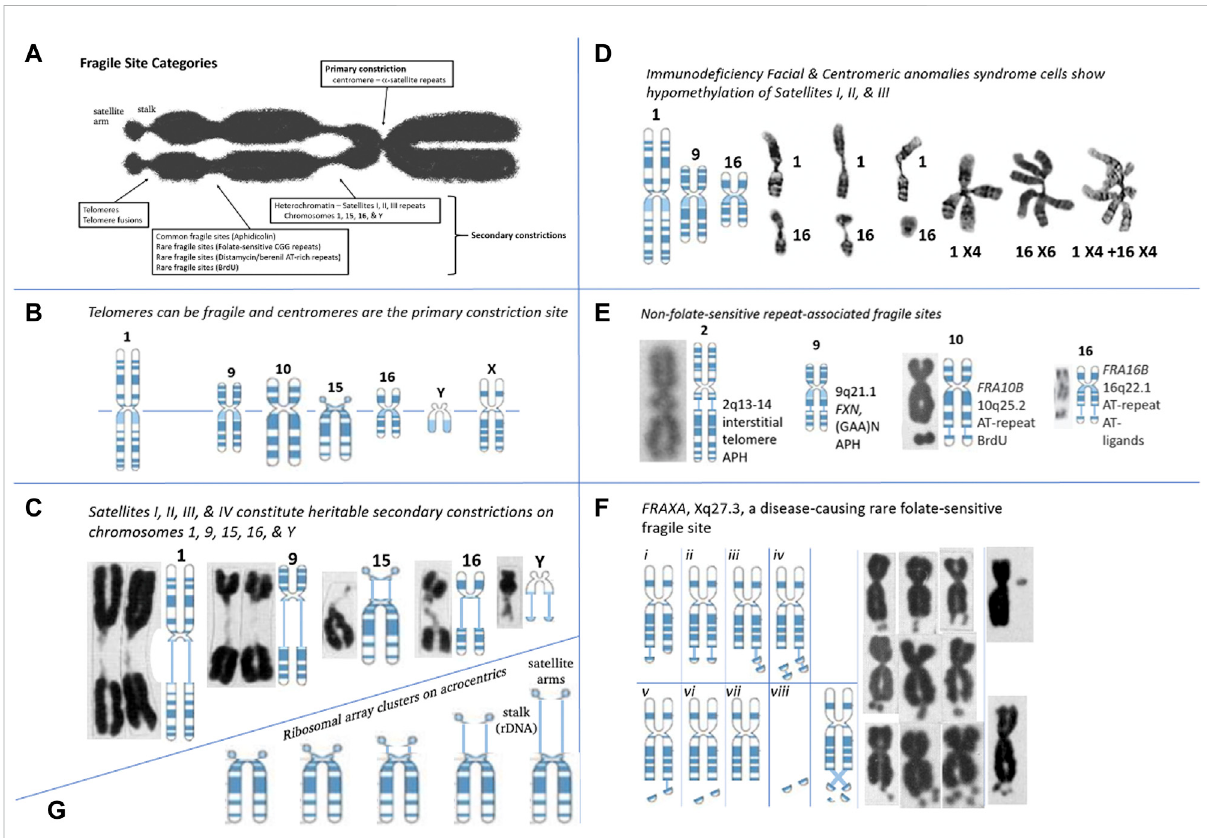
FIGURE 1 Repeat Tracts, fragile sites, and disease. (A) Categories of fragile site constrictions observable on human chromosomes. (B) Fragile sites can occuratthetelomereorcentromere,observedonchromosomes1,2,9,10,15,16,Y,andX.Telomereendsdisplay “ fragile-sitelike ” appearancesthat areTRF1-dependantandAPHinducible(Sfeiretal.,2009).Thecentromereofeverychromosomeisthe “ primaryconstriction, ” composedofrepeats. (C) Secondary constrictions are present on chromosomes 1, 9, 16, 15, and Y. Cytogeneticists were aware of these gaps prior to FRAXA and modeled it after the secondary constrictions (Lubs, 1969). These are composed of the classical satellite repeat DNAs, where four types (I-IV) of satellite DNA are located in the heterochromatic regions of chromosomes 1, 9, 15, 16, and Y, the total amount on these chromosomes and the proportion of the types being different (Vogt, 1990). Satellite regions of chromosomes 9 and Y, whose composition is the most complicated, and chromosome 15 is less complex, but like 9 and Y, it comprises all four types of satellite DNA. Chromosome 1 has type II satellite DNA, with the proportion of the remaining types being less. The C segment of chromosome 16 comprises only type II. The size/length of the secondary constrictions is highly-polymorphic amongst individuals, and segregates as a heritable state (Chromosomes: Guttenbach and Schmid, 1994). (D) In Immunode fi ciency,Centromericinstability&Facial anomalies(ICF) syndrome, satellitesI,II,andIIIofchromosomes1,9,and16arehypomethylated and show secondary constrictions within these regions. ICF syndrome was recently shown to be caused by four mutations in four genes: ICF1/ DNMT3B , ICF2/ZBTB24 , ICF3/CDCA7 ,and ICF4/HELLS (vandenBoogaardetal.,2017).Satellite-containingregionsonchromosomes1,9,and16are hypomethylated in individuals affected by ICF syndrome, and these show a variety of aberrant chromosomes: secondary constrictions, multibranched chromosome arms, whole arm deletions, duplications, isochromosomes, and centromeric fragility. As with fragile sites, these involved double-strand DNA breaks (Sawyer et al., 1995; Tuck-Muller et al., 2000). (Chromosomes: Tuck-Muller et al., 2000). (E) Many non-folate sensitive fragile sites have been mapped at repetitive regions. The interstitial telomeric repeat on chromosome 2, the AT-repeats of FRA10B and FRA16B,andtheGAArepeatof FXN onchromosome9has “ fragile-like ” characteristics.Fragilesiteat2q13-14ataninterstitialinvertedhead-to-head array of the telomeric repeat (TAGAGGG)54-(CCCTAA)104, a result of an ancient telomeric fusion, not “ telomere healing ” event (IJdo et al., 1991; Bosco and de Lange, 2012). Notably, there are other interstitial telomeric sequences (Wells et al., 1990). A “ fragile-like ” site has been reported at 9q21.1 in the expanded (GAA)N repeat in FXN , which causes Friedreich ’ s ataxia (Kumari et al., 2015) . FRA10B at 10q25.2 is induced by BrdU and mapped toan expanded ~42bp AT-rich minisatellite repeat(Sutherland etal.,1980;Hewett etal.,1998)(Chromosomes: Boscoand deLange,2012; Sutherlandetal.,1980;Felboretal.,2003). (F) Variouspresentationsofthe FRAXA siteinCGG-expandedFXSpatientcells(Crippaetal.,1984;Fitchett and Seabright, 1984; Savage and Fitchett, 1988): chromatid breaks/gaps, isochromatid breaks, isolated double-minutes, deleted X ’ s, secondary duplications (double satellite). Satellite association and variations in length of the nucleolar constriction of normal and variant human G chromosomes. (Chromosomes: Lubs, 1969). (G) Ribosomal DNAs can vary the length of the chromosome by varying lengths of the secondary constrictions (stalks) of the acrocentrics (Chr 13, 14, 15, 21, and 22) on which they reside (Orye, 1974; Cheung et al., 1989; Heliot et al.,